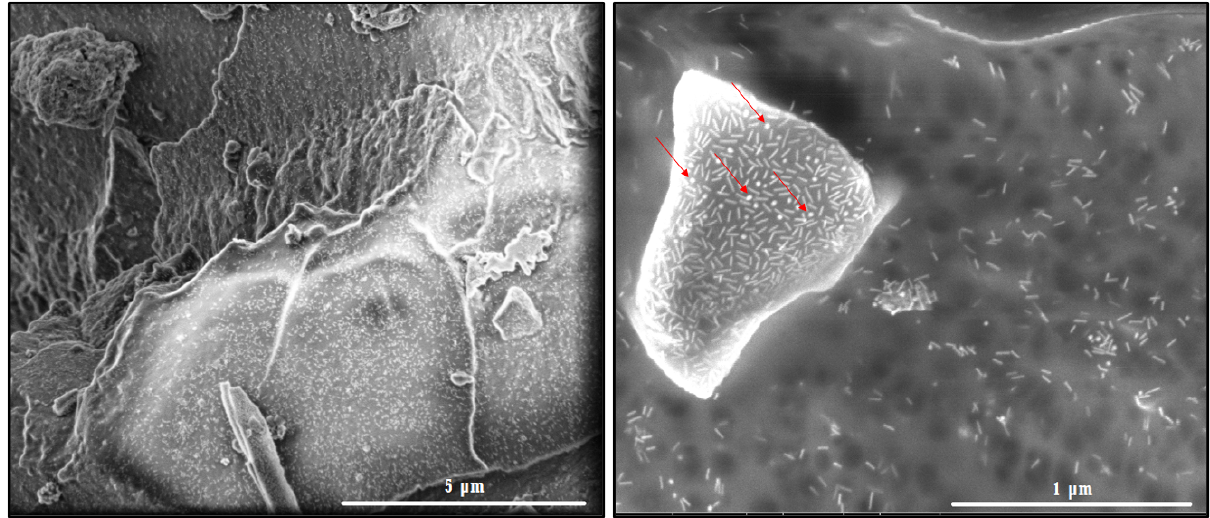
Figure 12. FE-SEM of the ICs associated with the AuNRs. The red arrows (right panel) highlight the impurities ascribed to spherical gold nanoparticles.